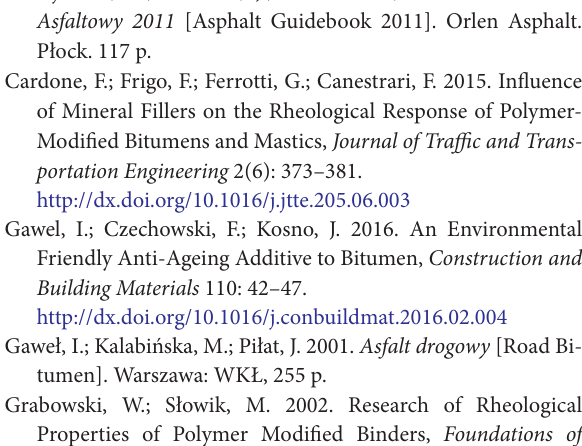
Table 4. The collection of statistical analyses of properties of bitumen extracted from SMA pavement ( p -value < 0.05) Univariate results for each DV over-parameterized model type III Effect